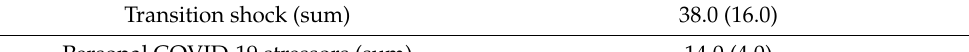
Table 1. Cont. Transition shock (sum)